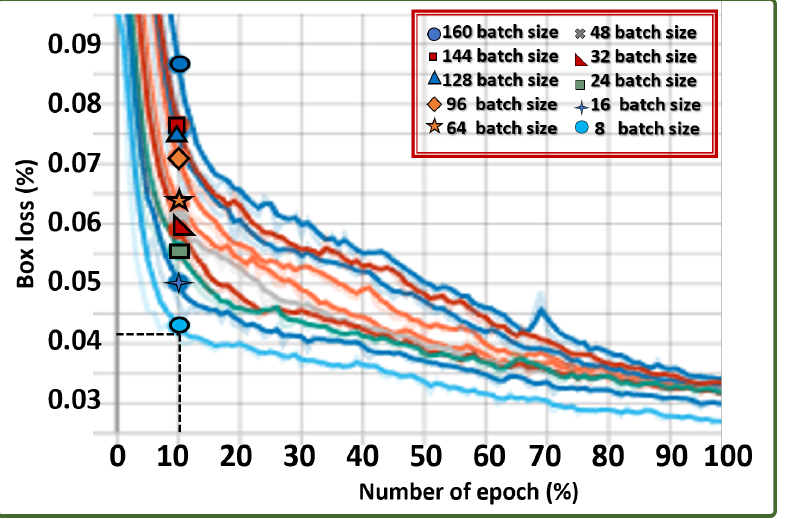
Figure 12. Box loss graph across different batch sizes indicating ALIEN’s learning capability in predicting results on different operation quanta.